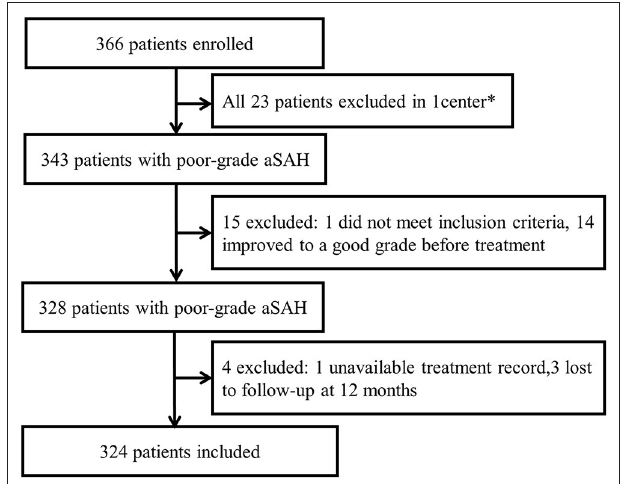
FIGURE 1 | Study flow diagram. *One center was excluded because enrollment was not consecutive and patients were lost to follow-up.